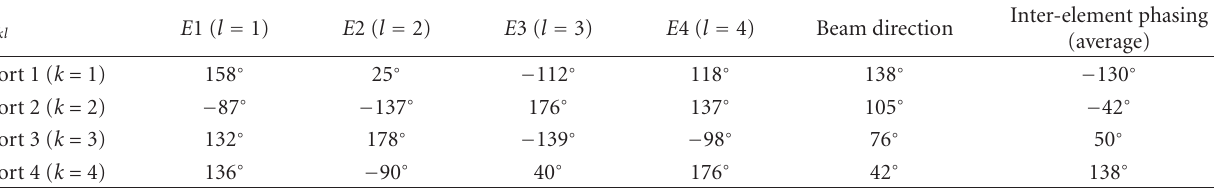
Table 2: Element phasing, beam direction, and interelement phasing for the Butler matrix shown in Figure 4